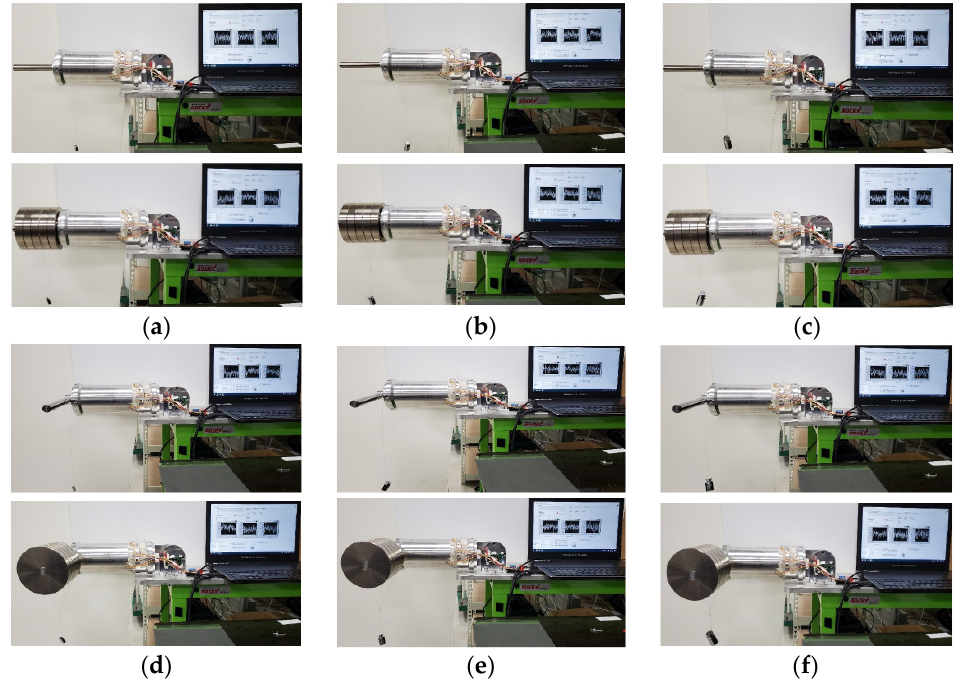
Figure 9. Weight (10 g, 50 g, 100 g) test with or without initial weight (10 kg): ( a ) bending moment by 10 g; ( b ) bending moment by 50 g; ( c ) bending moment by 100 g; ( d ) torsional moment by 10 g; ( e ) torsional moment by 50 g; ( f ) torsional moment by 100 g.